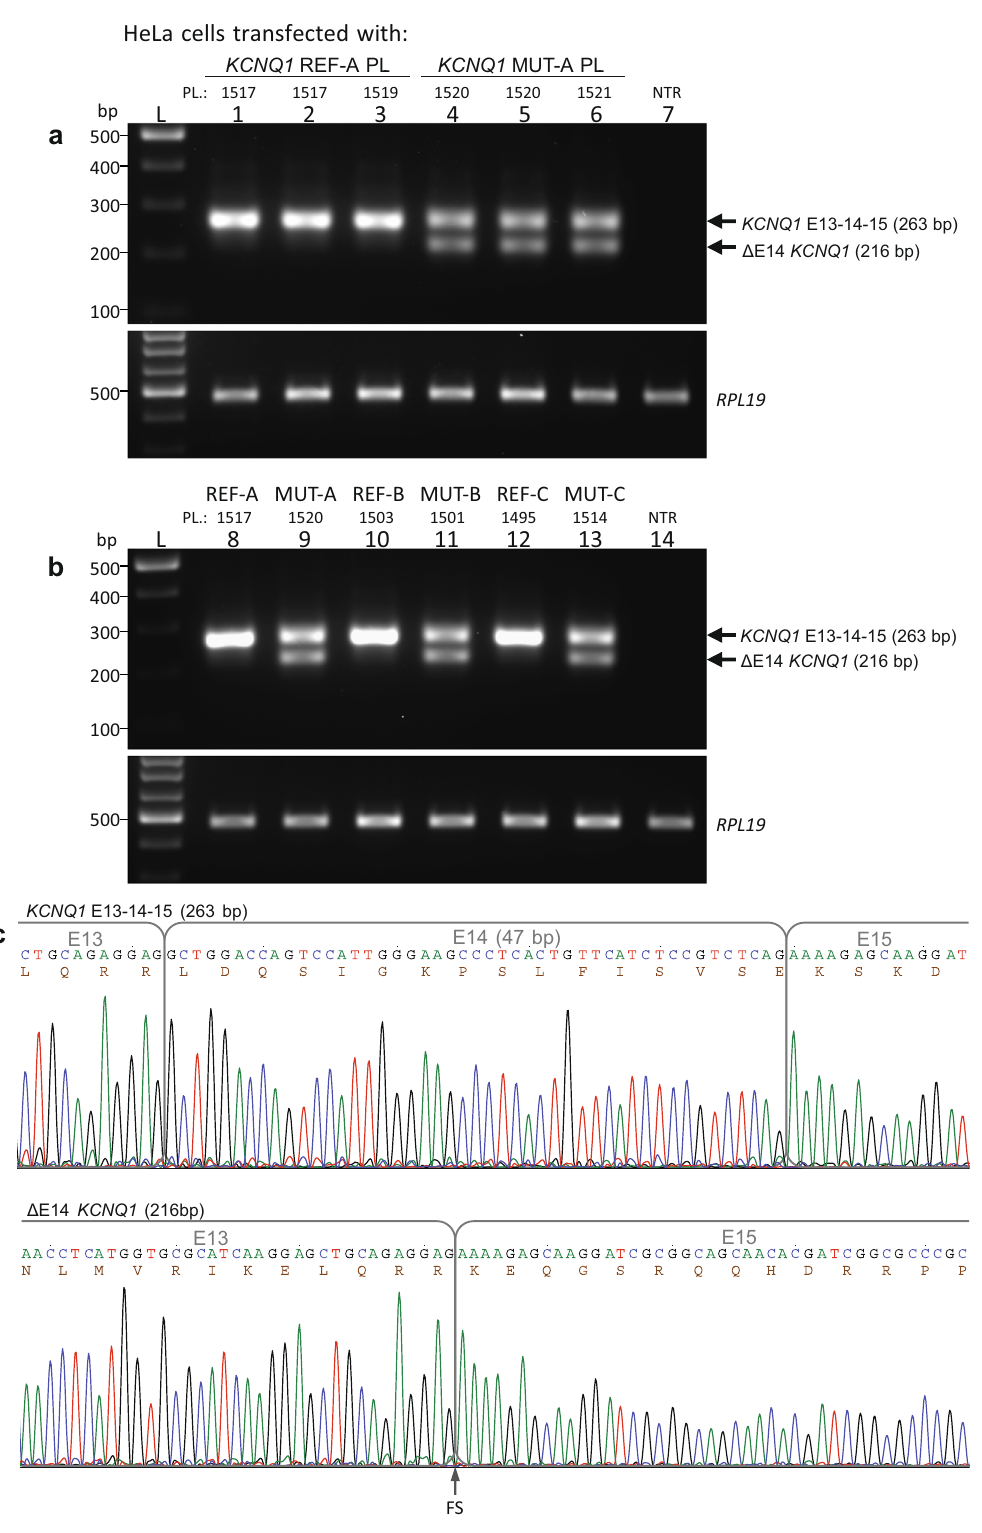
classi fi ed as likely pathogenic based on the following criteria: PS3 (functional studies supportive of a damaging effect on the gene or gene product), PM2 (the variant is absent from controls in gnomAD) and PM3 (for recessive disorders, detected on opposite chromosomes with a pathogenic variant, which requires testing of parents to determine